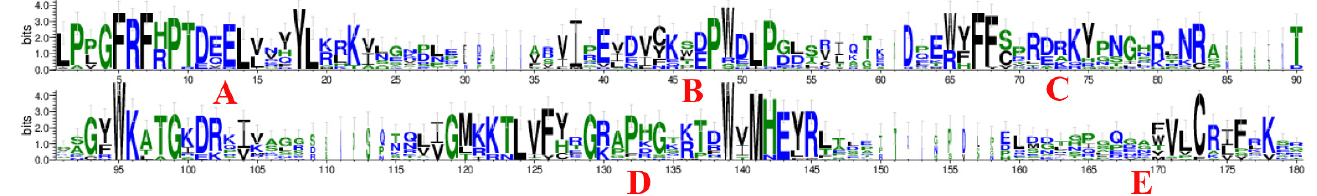
Figure 3. Conserved domain of LiNAC family by Jalview software and Weblogo. (A–E) represent five subdomains.